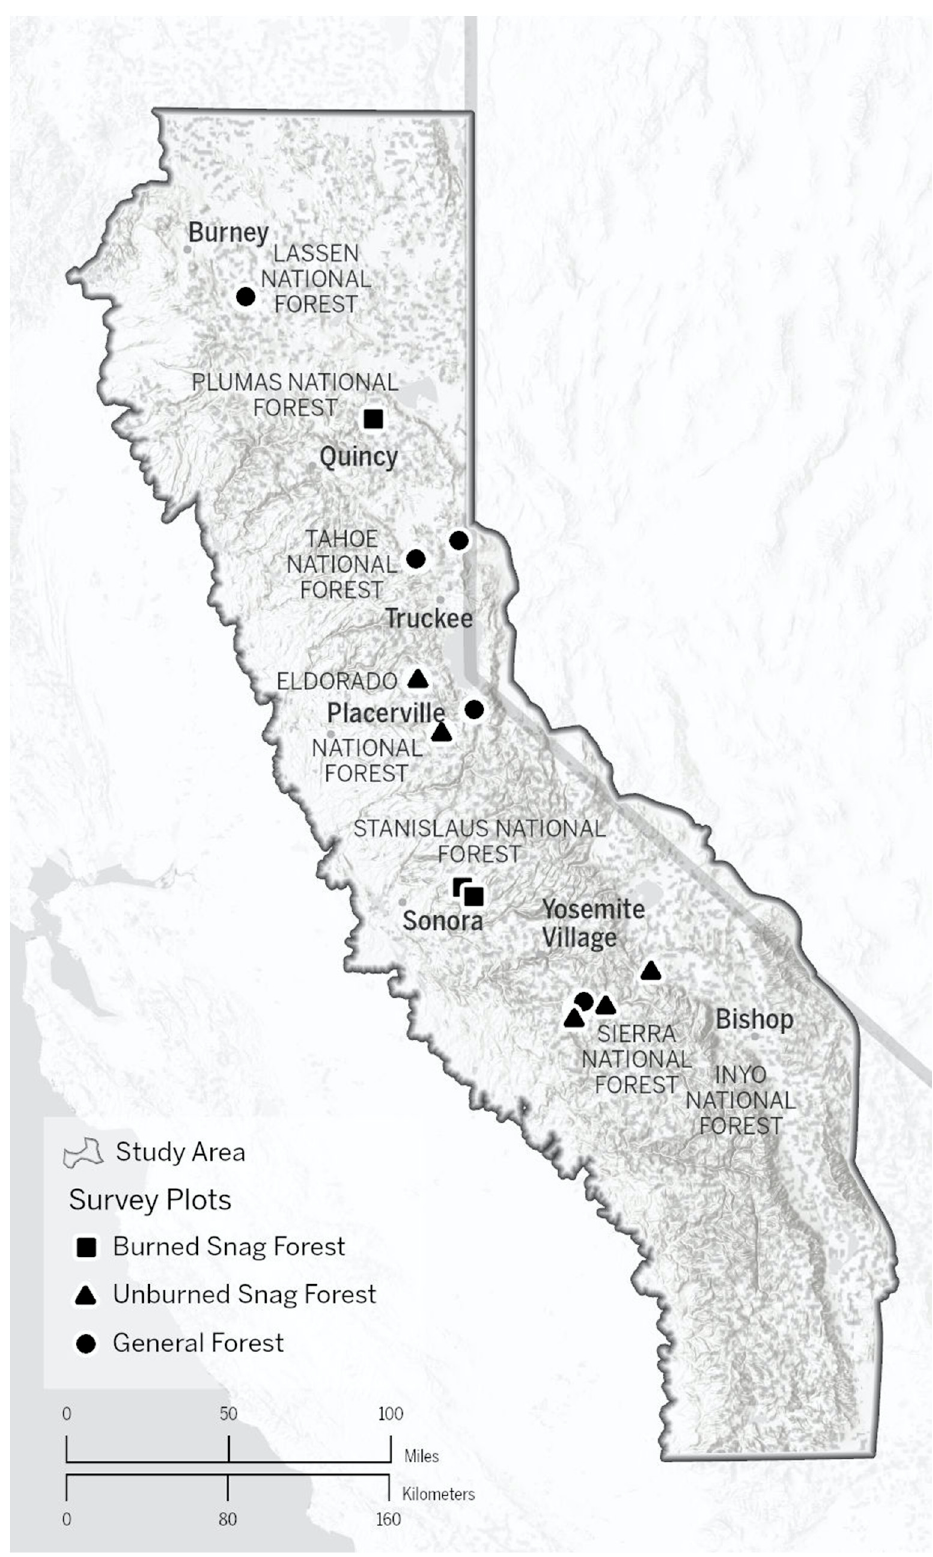
Figure 1. The study area, with the locations of plots in each of the three habitat conditions.